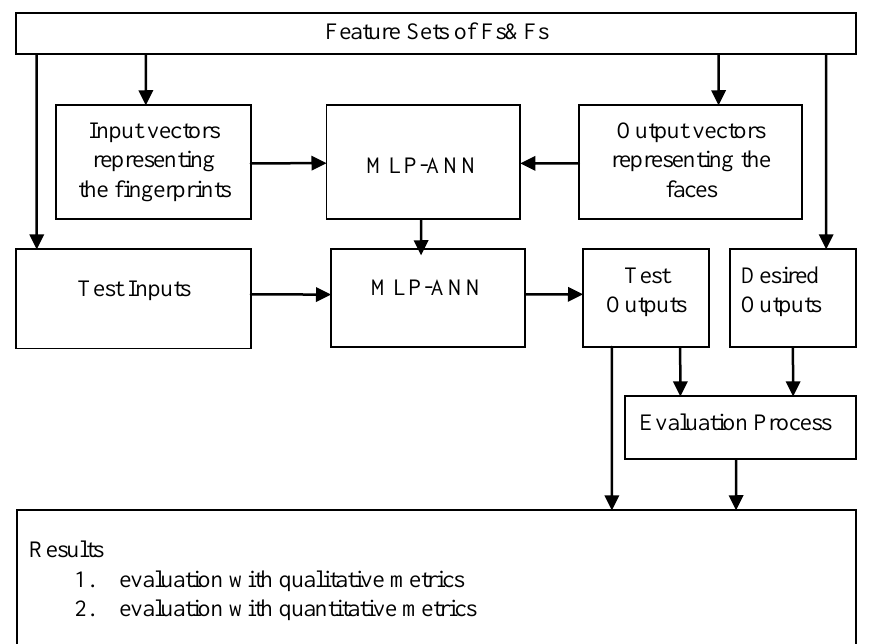
Figure 9. The block diagram of the MLP NN